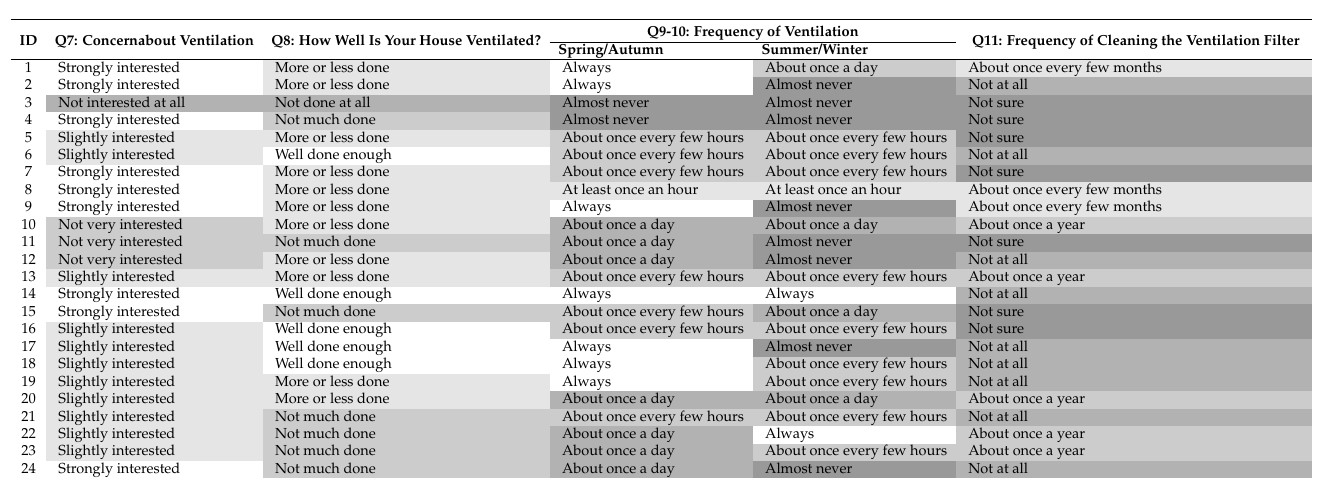
Table 4. Responses to questions about ventilation concerns and behaviors. The darker the color of the answer, the worse it is for indoor air quality.